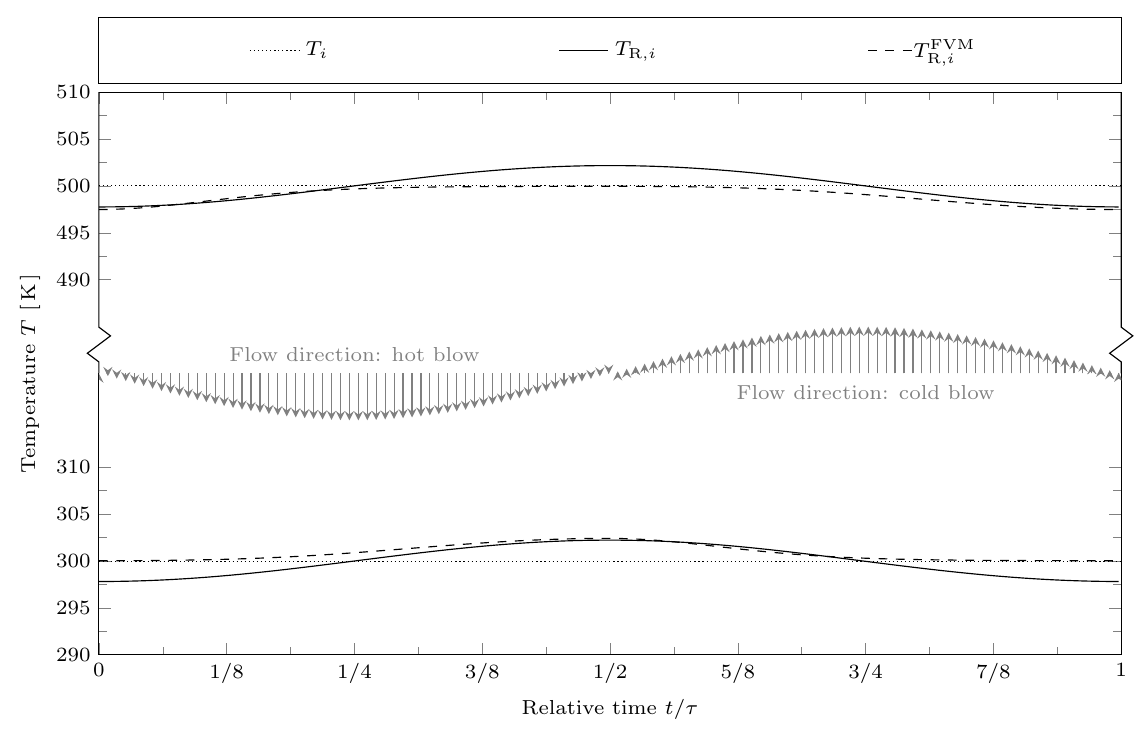
T ES -regenerator model (solid lines) compared to the contact point Figure 9. Contact point temperatures T R,H and R,L of the temperatures of a finite volume benchmark regenerator model T FVM R,H and T FVM R,L (dashed lines) for the internally reversible case Σ S R : = 0. The constant temperatures of the adjacent gas reservoirs T H and T L are plotted with dotted lines. The contact point temperatures T R,H and T R,L overshoot T H and undershoot T L , respectively, due to the assumption of the linear temperature profile made in the ES -regenerator model. Apart from that, the regenerative behavior is well approximated regarding amplitude and phase of the temperature oscillations, despite the fact that the ES -regenerator model has only two degrees of freedom and much lower numerical